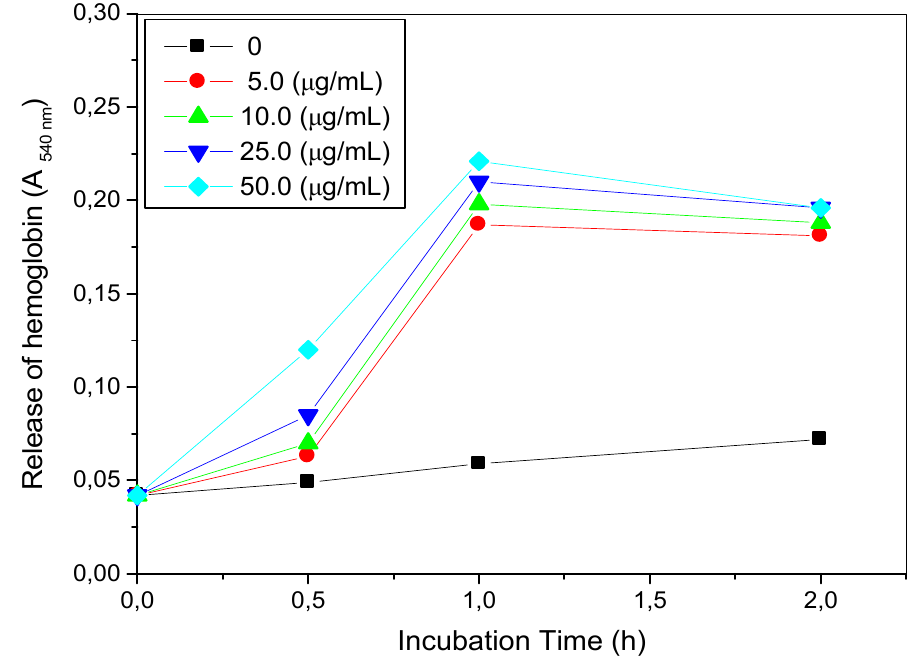
Figure 2. Hemolysis of erythrocytes induced by saponin white at concentration ranged from 0 to 50 μ g/mL of saponin, which was examined during incubation time for 0 to 2 h. Hemolysis is expressed as in Figure